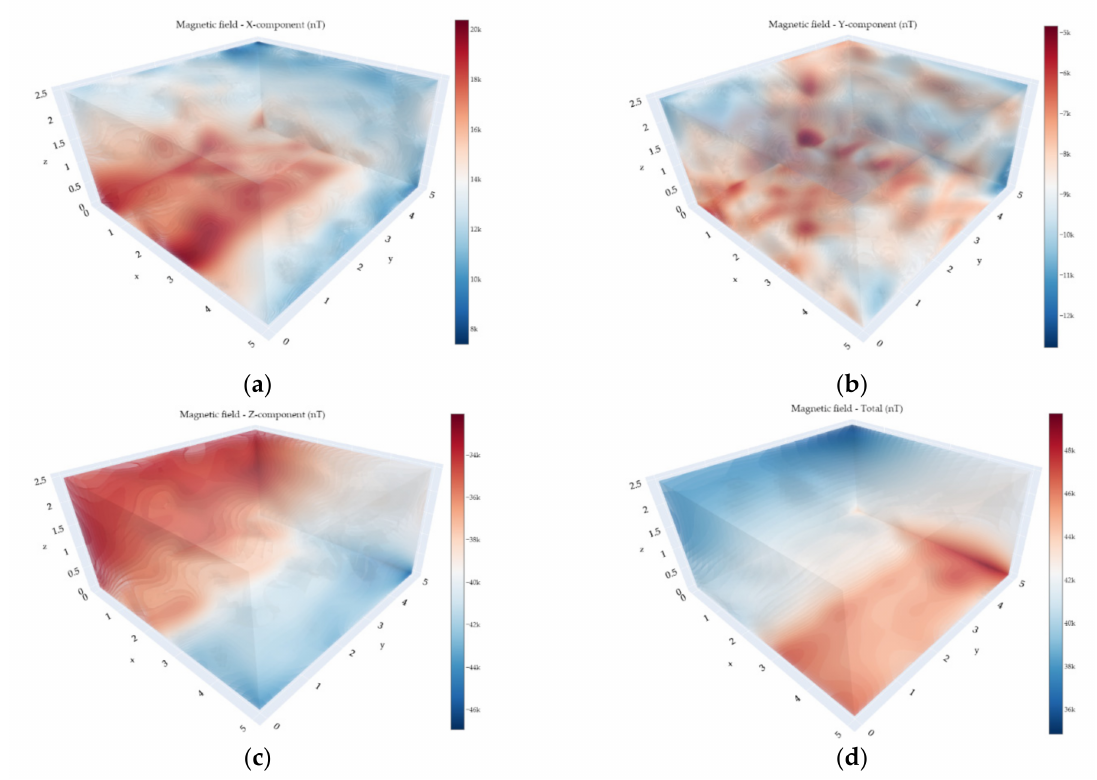
Figure 13. The DC (Direct Current) magnetic field measurements with the VEMA magnetometer: ( a ) X-component; ( b ) Y-component; ( c ) Z-component; ( d )